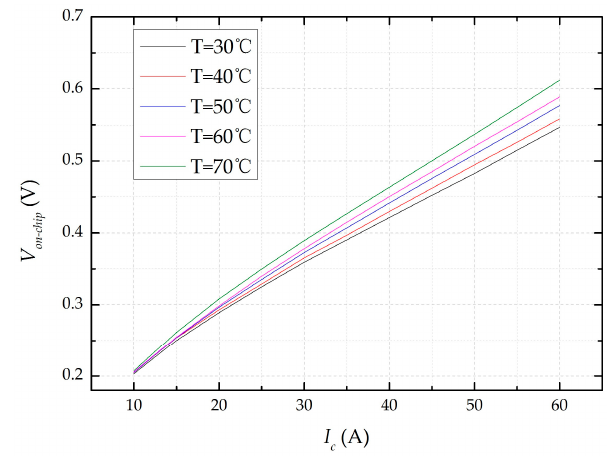
ff erent junction Figure 5. On-state chip voltages at different junction temperatures. Figure 5. On-state chip voltages at different junction temperatures. Figure 5. On-state chip voltages at di